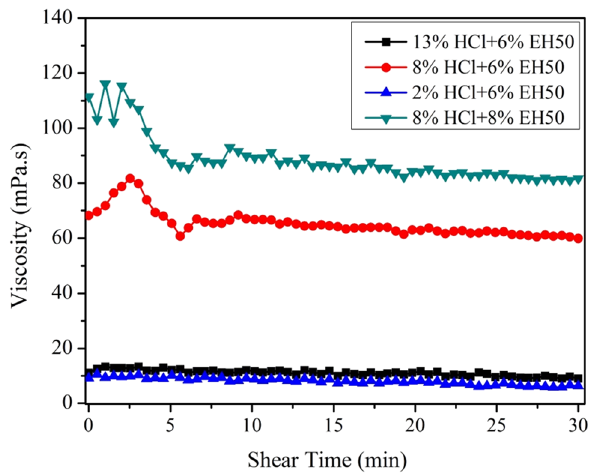
Fig. 3 The viscoelastic surfactants of the diverting acid at different concentrations ( T = 60 ℃ , rate of shear 170 S − 1 )